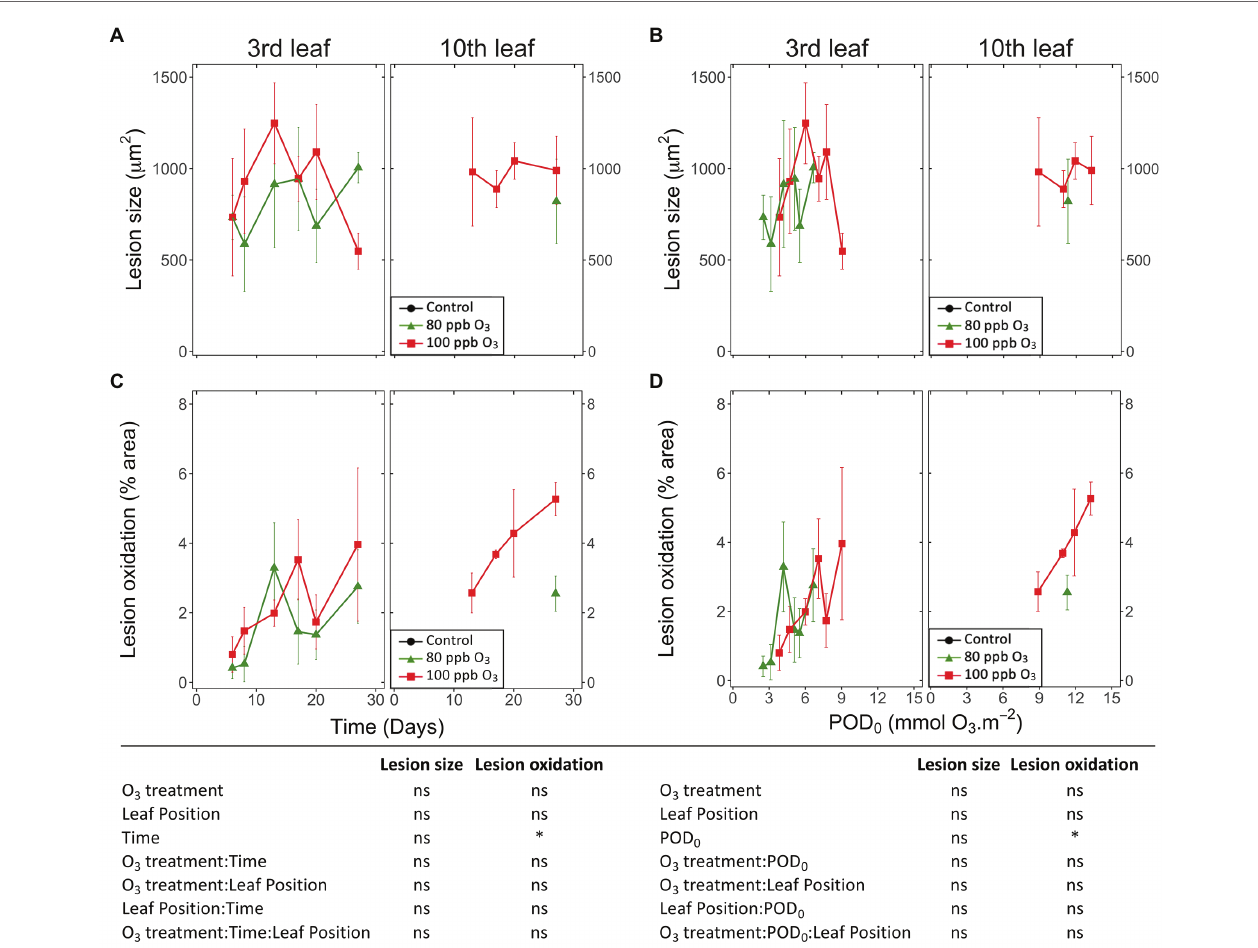
FIGURE 6 | Dynamics of changes in the size (A,B) and degree of oxidation (C,D) of single HR-like lesions in hybrid poplar leaves ( Populus tremula x alba ), as a function of the assessment time (A,C) , phytotoxic O 3 dose (POD 0 ; B,D ), O 3 treatment (charcoal-filtered air ● , 80 ppb O 3 ▲ , 100 ppb O 3 ◼ ), leaf position and interactions [model: lmer(variable) ~ O 3 treatment ∗ leaf position ∗ time + (1 | tree/chamber); ∗ p ≤ 0.05; ns, not significantly different, na not tested]. (A,B) The size of HR-like lesions did not respond to the experimental factors and interactions. Values represent means ± SE of distinct lesion size (A,B) and percentage area showing oxidation (C,D) , n =